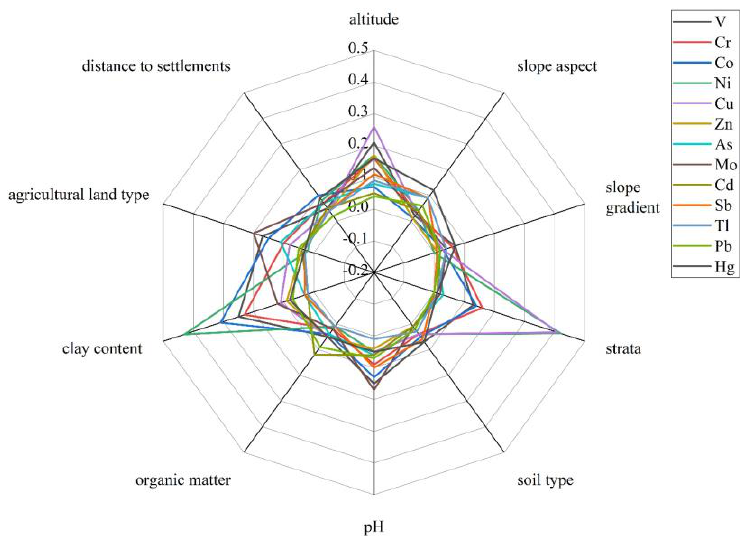
Figure 3. Polar graph of the q value of a single influencing factor on the contents of 13 PTEs.